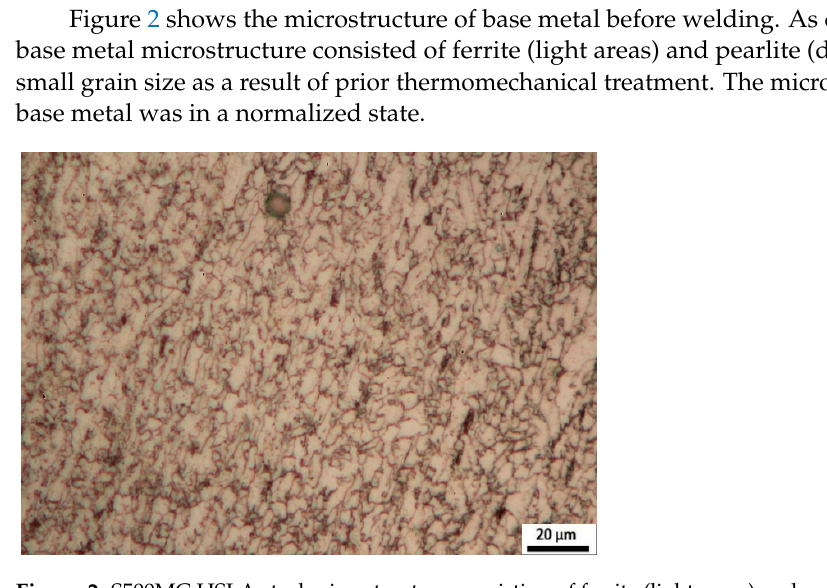
Figure 2. S500MC HSLA steel microstructure consisting of ferrite (light areas) and pearlite (dark areas).